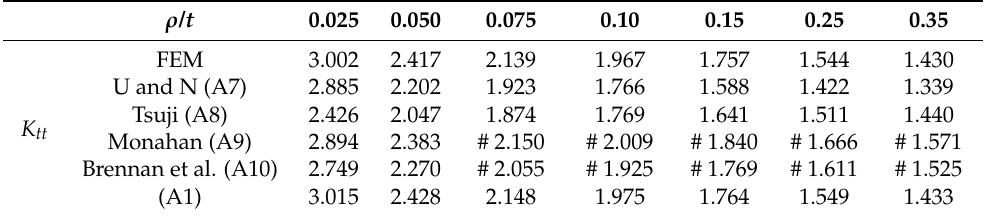
Table 9. Accuracy of Equations (A1) and (A7)–(A10) for a T-joint subjected to tension, where: θ = 45 ◦ ,